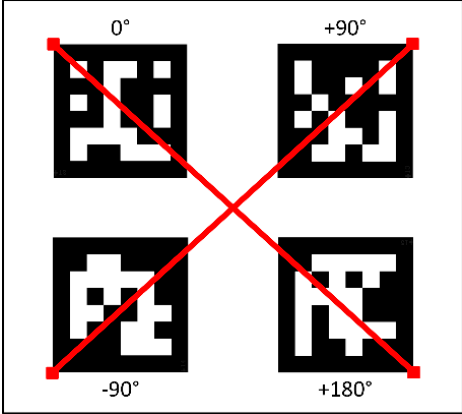
Figure 10. Markers are rotated to use OpenCV functions that provide their top left corner, calculate the diagonals and the intersection, defining UAV’s goal as landing destination.